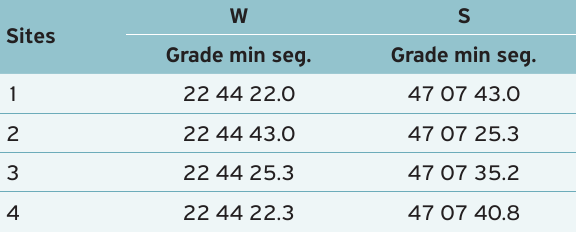
Table 1. Sampling sites in the Atibaia River